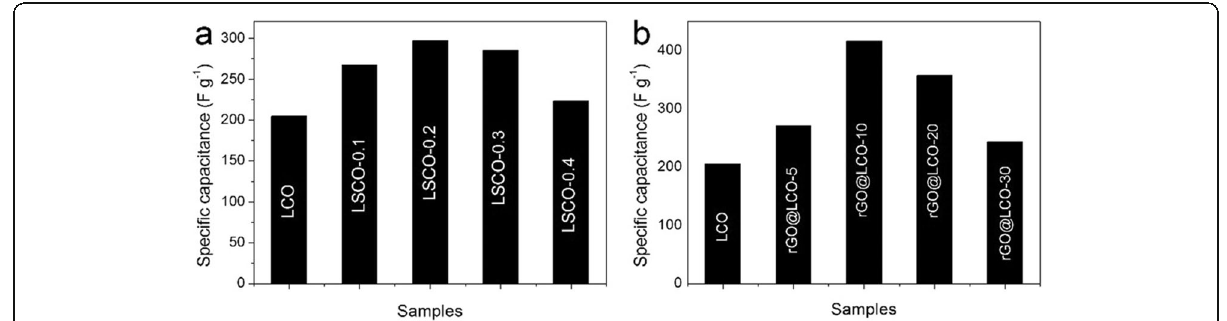
Fig. 3 The specific capacitance of a LSCOs, and b rGO@LCOs electrodes at 0.5 A g −